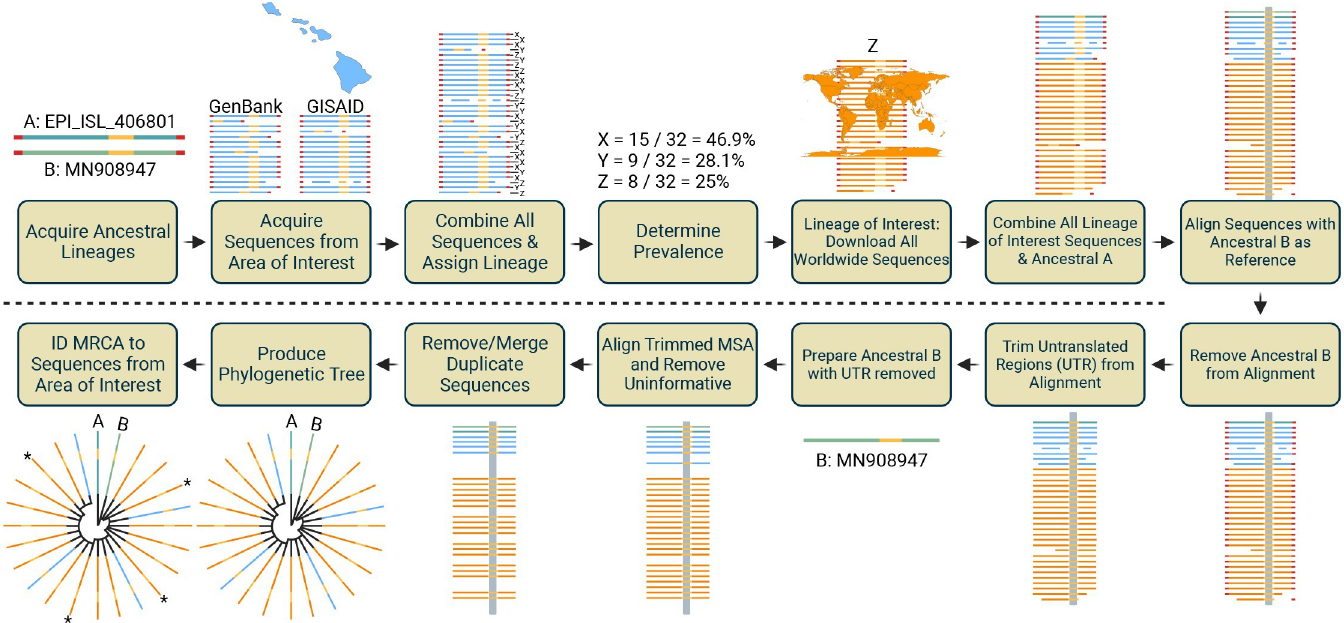
Fig 1. Workflow to generate phylogenetic trees and to identify MRCA. This figure outlines the 14 steps to define the origin of SARS-CoV-2 Variant of Concern (VOC) into an area of interest (demonstrated as Hawaii). Collectively, the workflow defines the VOC of a particular area, so research may identify a VOC of interest to conduct the workflow. Then all worldwide sequences of the selected VOC are aggregated into a Multiple Sequence Alignment (MSA). The MSA is modified to remove ambiguous and uninformative sequences and added to the ancestral lineages A (GISAID Accession # EPI_ISL_406801) and B (GenBank Accession # MN908947). Duplicate sequences are merged via their accession number (creating appendages), and the duplicates are removed from the MSA. An approximately maximum-likelihood phylogenetic tree is generated and rooted with ancestral lineage A. The identification (ID) of the most recent common ancestor (MRCA) of the sequences of interest defines the origin. Maps generated with the open-source “usmap” and“ggplot2” packages and R under GPL-3 and MIT+ license and are free to use (https://cran.r-project.